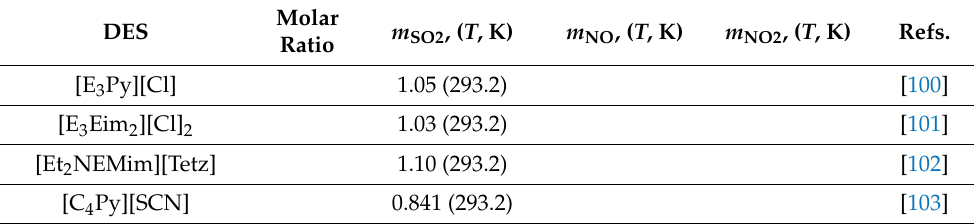
Table 2. Cont. DES